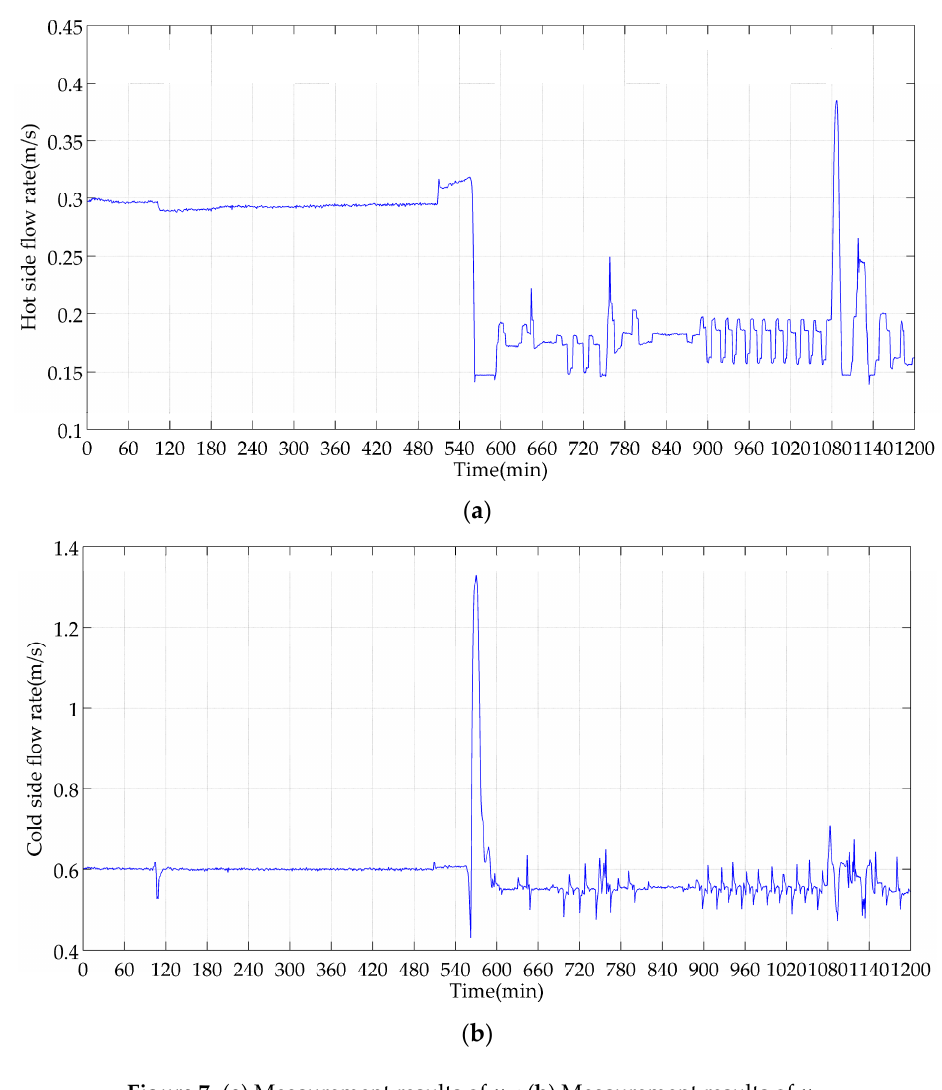
Figure 7. ( a ) Measurement results of h u ; ( b ) Measurement results of c u .